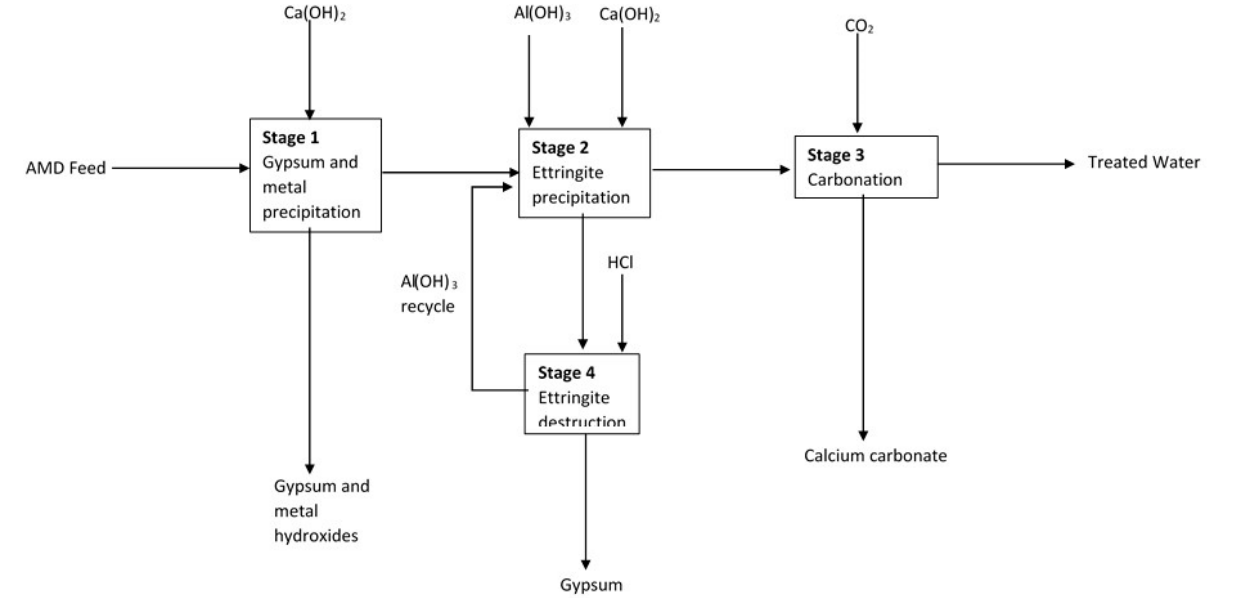
Figure 1. AMD water treatment flowsheet.